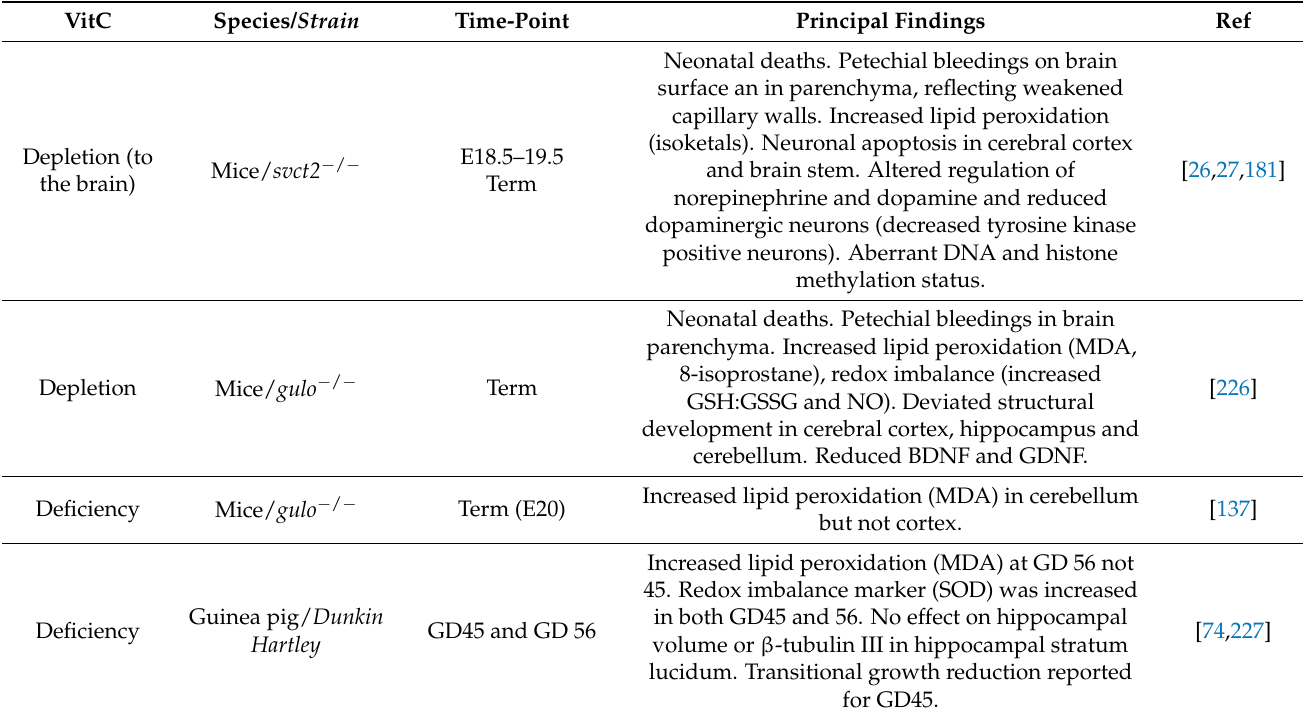
Table 1. Principal findings of prenatal vitamin C deficiency—findings from experimental animal